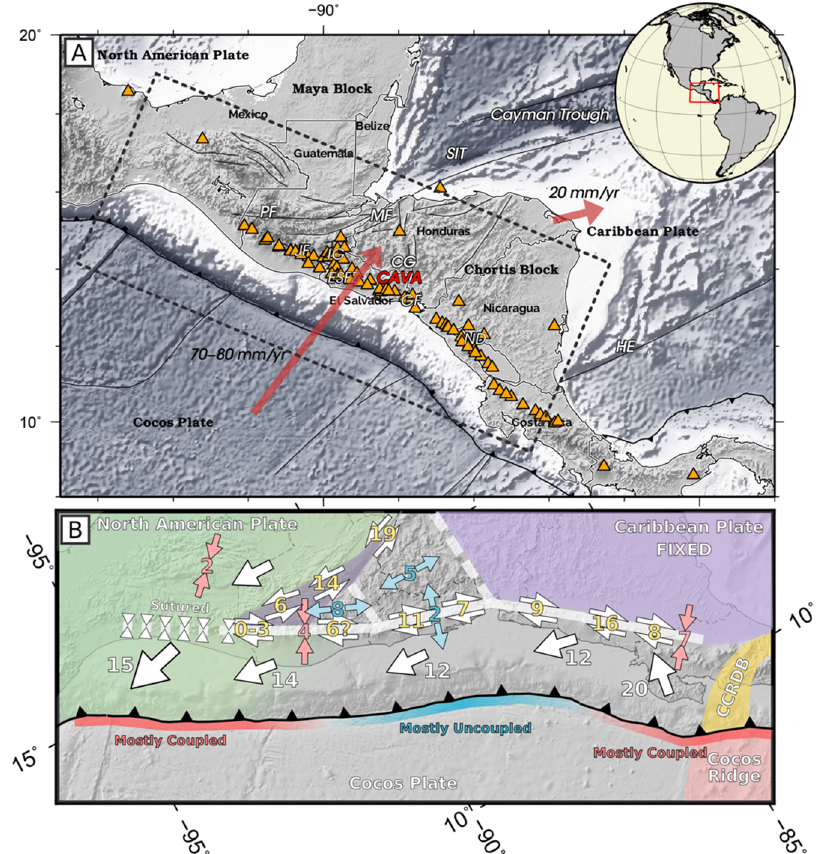
Figure 1. ( A ) Geodynamic sketch of northern Central America with the main regional tectonic features. Red arrows are the GPS site velocities relative to the North American Plate fixed (according to [43]). PF: Polochic fault; MF: Motagua Fault; IG: Ipala graben; CG: Comayagua graben; SIT: Swan Island Transform Fault; JF: Jalpatagua Fault; ESFZ: El Salvador Fault Zone; ND: Nicaraguan Depression; GF: Gulf of Fonseca; HE: Hess Escarpment; CAVA: Central American Volcanic Arc. Orange triangles are the Holocene volcanoes from [44]. Rectangle shows the location of Figure 1B ( B ) Kinematic model proposed with average velocities of blocks and faults (modified from [38]). The numbers show velocities in mm/yr. Yellow numbers are the strike slip velocities, blue for extension and red for shortening. The large white arrows show the horizontal motion of blocks. The red shaded area shows the Cocos Ridge bathymetric features, and the yellow shaded area represents the Central Costa Rica Deformed Belt (CCRDB). The subduction is segmented in three sections with a different coupling. White triangles show the sutured zip-type plate contact.